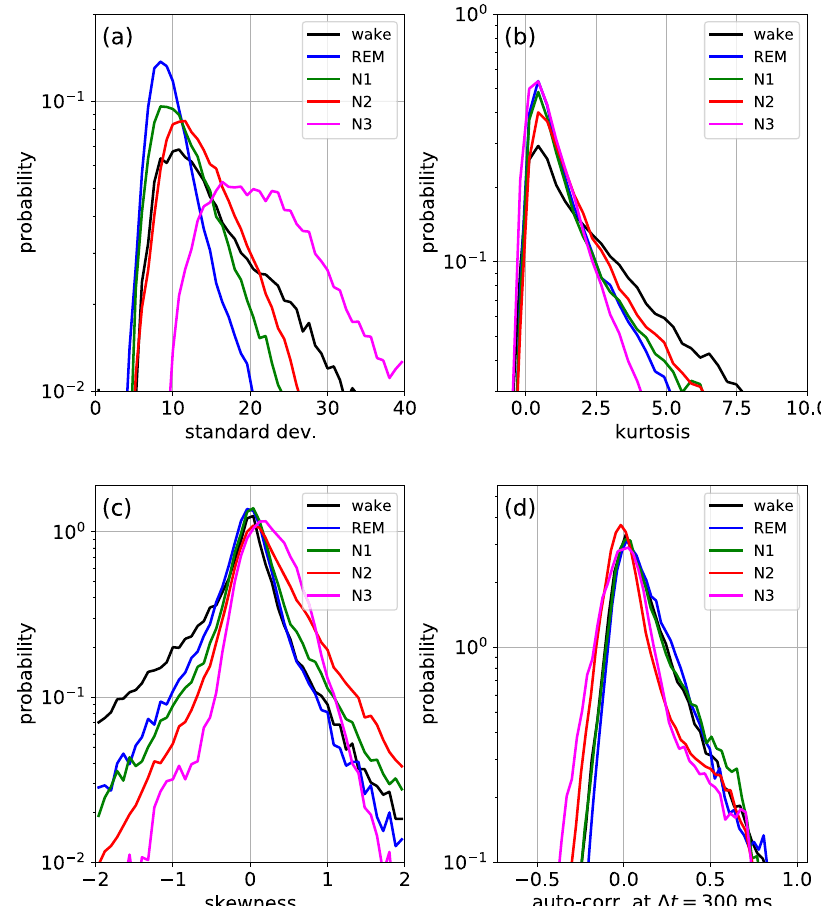
Fig. 3 Sleep-stage-dependent distributions of selected hyper-parameters. Probability density distributions of hyper-parameters extracted from the raw EEG data shown in Fig. 1. a Standard deviation STD. b Kurtosis KUR. c Skewness SKE. d Autocorrelation at lag time 300 ms, denoted as